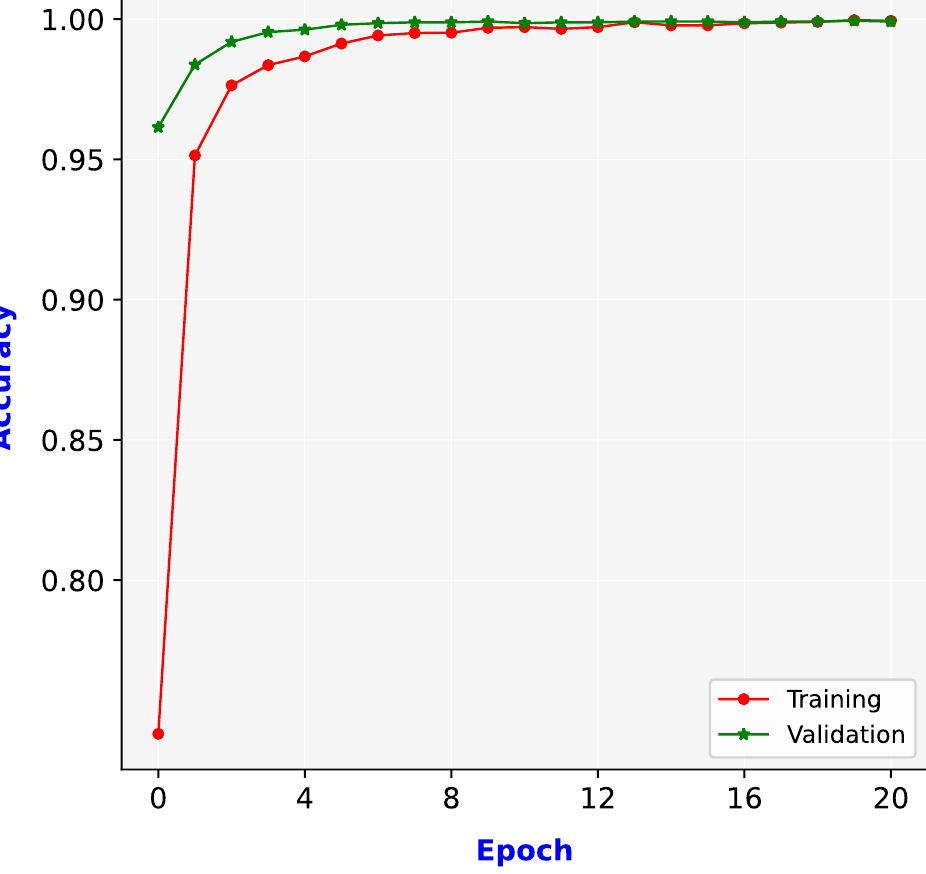
Figure 10. Training and validation accuracies for the constructed